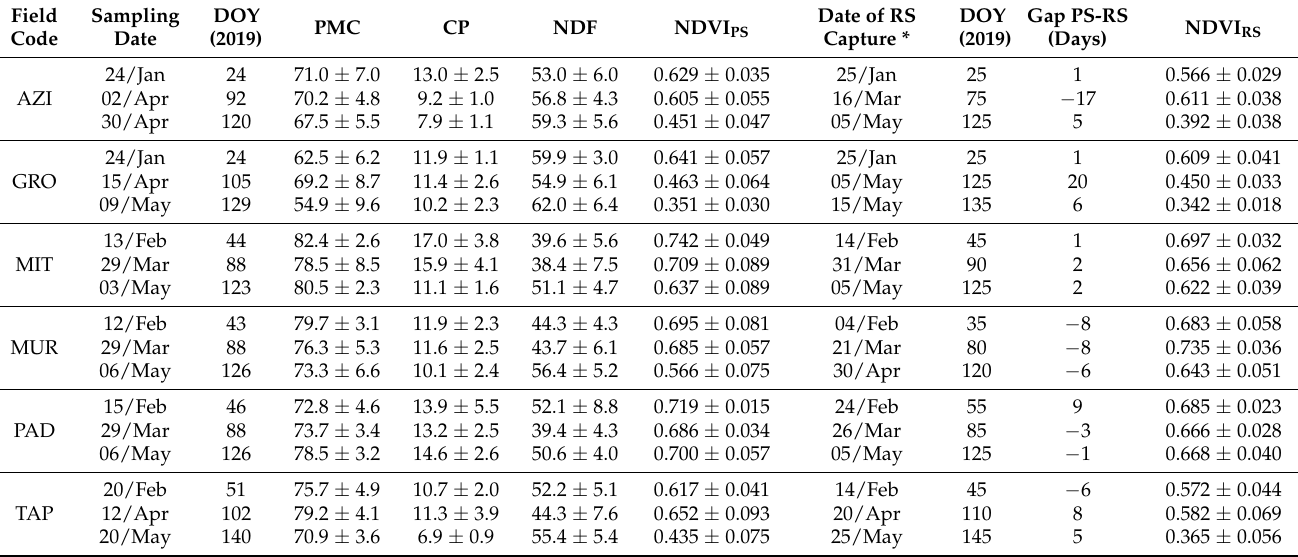
Table 2. Mean ± standard deviation of pasture parameters (PMC, CP, and NDF) and NDVI obtained by proximal and remote sensing in 2019.